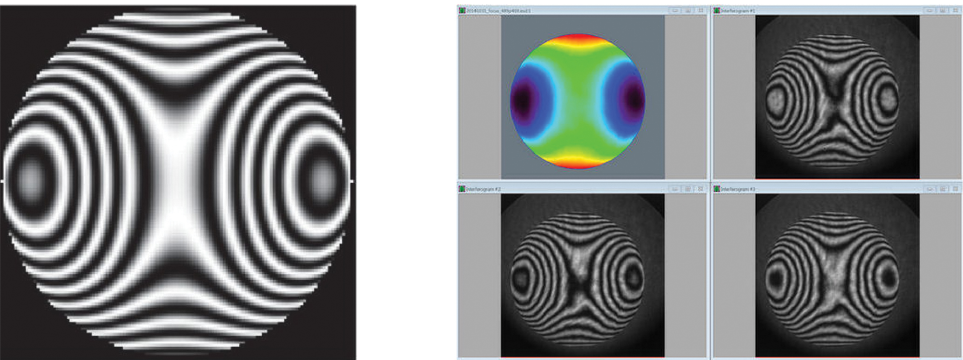
Figure 13: (Left) Computed He-Ne interferogram from a null-test single-lens compensator. (Right) Obtained He-Ne in- terferogram with the same null-test compensator. NB, The fringes represent the non-axisymmetric part of the freeform surface